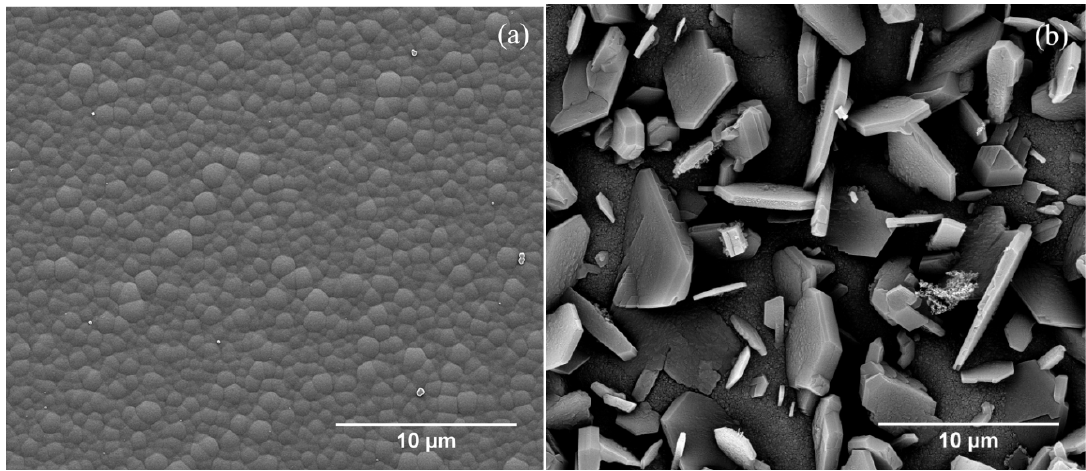
Figure 7. Scanning electron microscopy (SEM) images of samples ( a ) BC-1 and ( b ) BC-2. The much higher crystallinity of BC-2 is apparent from large facets with very fine-grained morphology between facets.